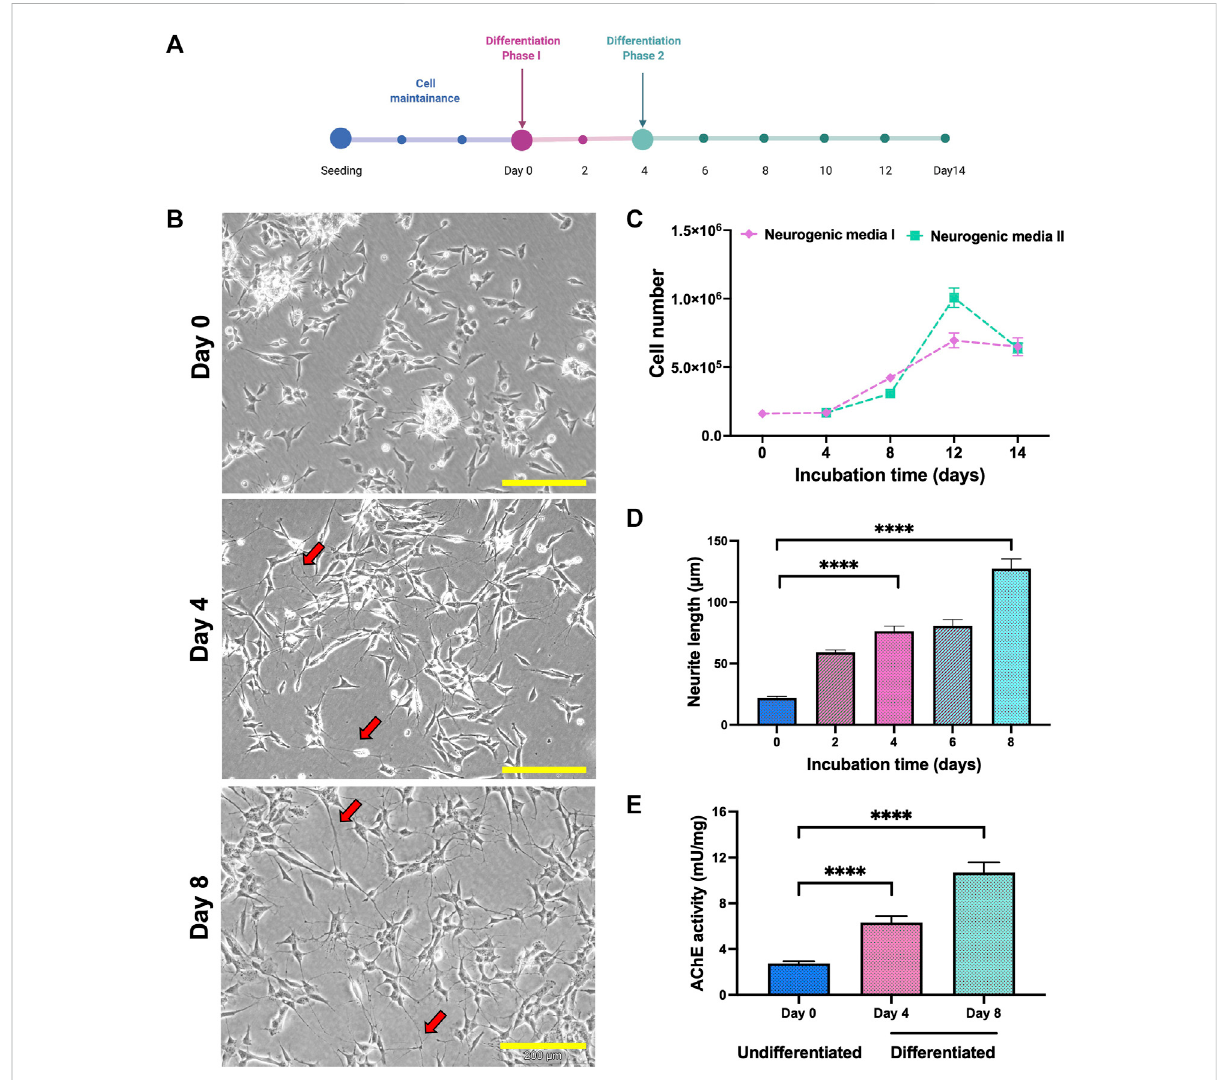
FIGURE 1 DifferentiationofSH-SY5Ycells. (A) SH-SY5Yweredifferentiatedasinthelinechart. (B) PhasecontrastofSH-SY5Ycellsmorphologyondays 0, 4 and 8. Neurite extension labelled in red arrow. Scale bar = 200 μ M. (C) Differentiation of SH-SY5Y showed modi fi cation in the cell number, (D) neurite length and (E) AChE activity. Data were presented as means ± SD, where p < 0.05 is considered signi fi cant. **** indicated p <